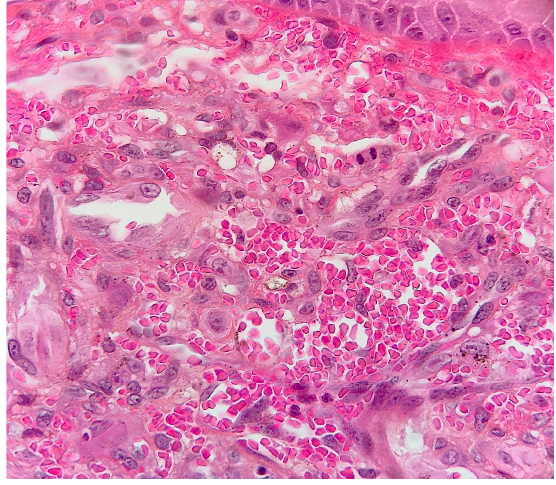
Figure 4. The characteristic epithelioid cells with ample, eosinophilic cytoplasm, and large, centrally located nuclei with conspicuous nucleoli are well visible; some of them contain red blood cells within intracytoplasmic lumina. Note the numerous extravasated red blood cells and haemosiderin